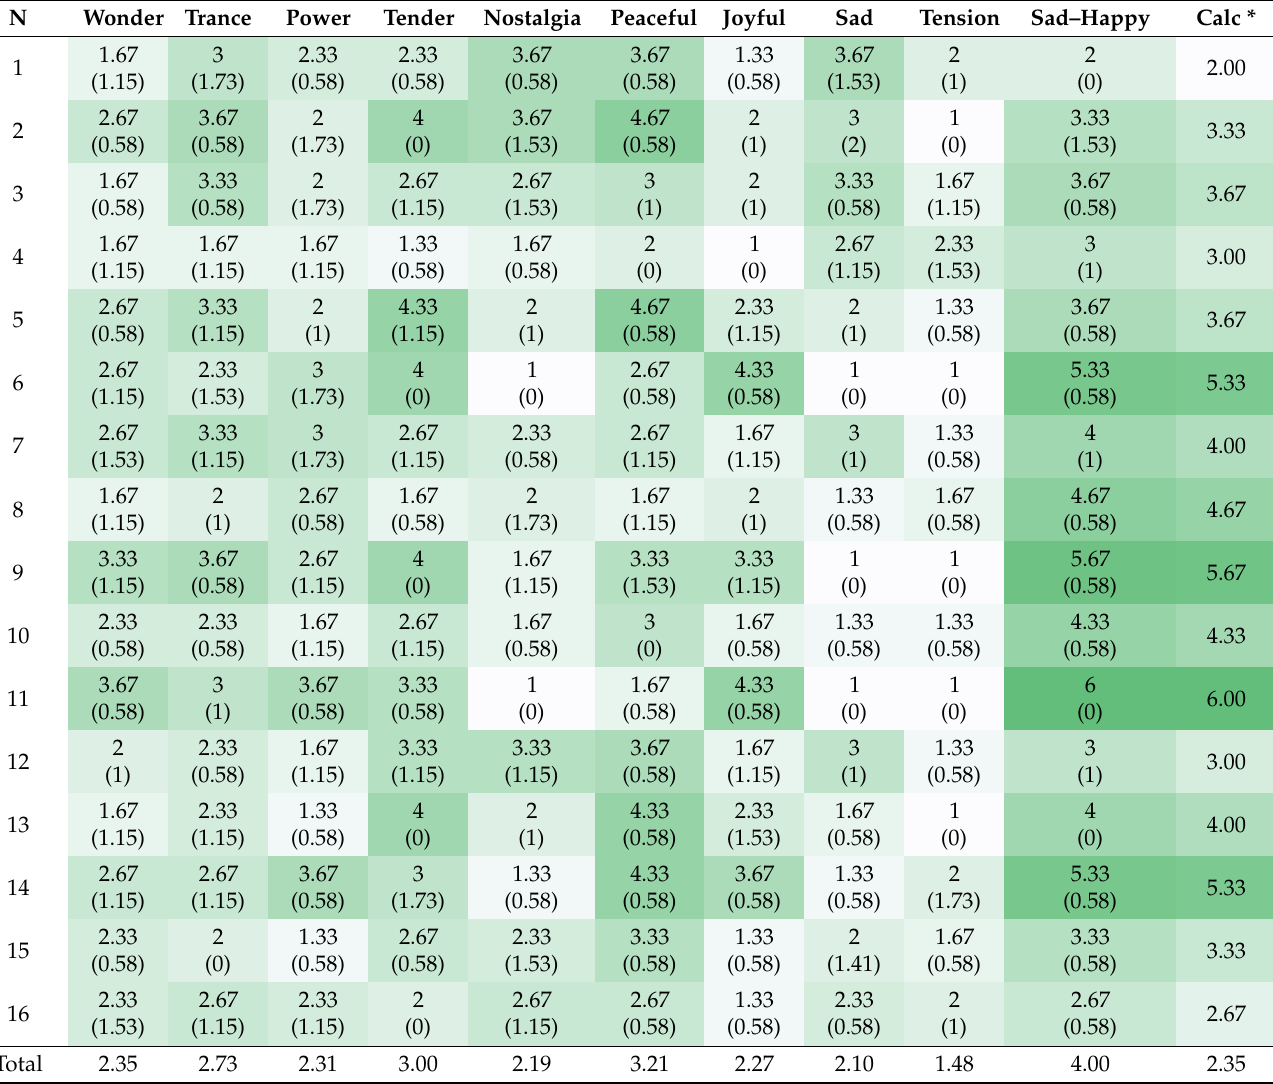
Table 2. GEMS-9 tool results from the nurses. The dark color indicates that the following emotional values are